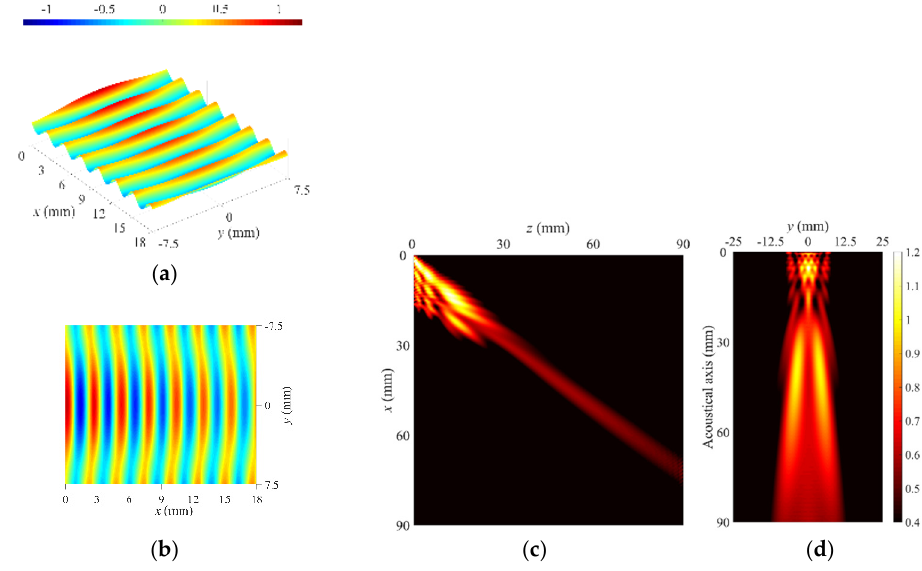
Figure 14. Simulation #3 of the leaky radiation beam profile based on the wave phase on the radiation surface. ( a ) Isotropic view of wave phase on radiation surface, ( b ) top view of wave phase on radiation surface, ( c ) vertical beam profile, and ( d ) lateral beam profile.